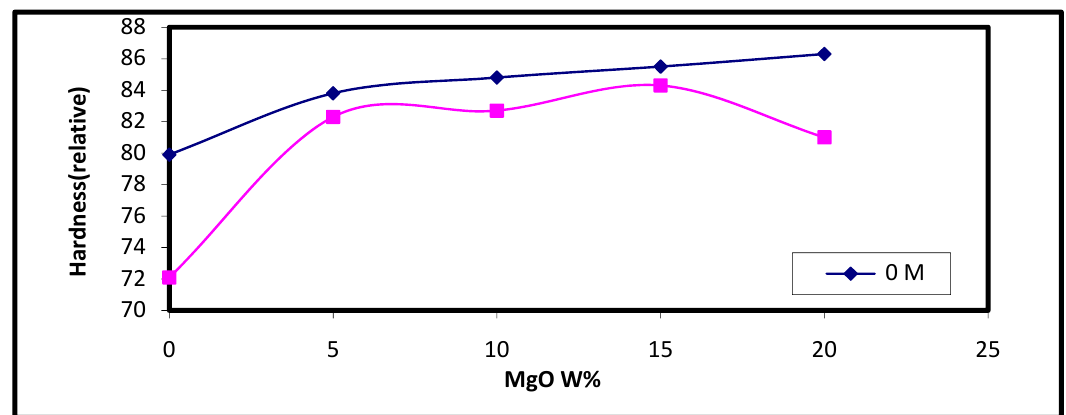
Fig. 2: The variation of hardness of the composite samples as a function of MgO wt%, before and after.